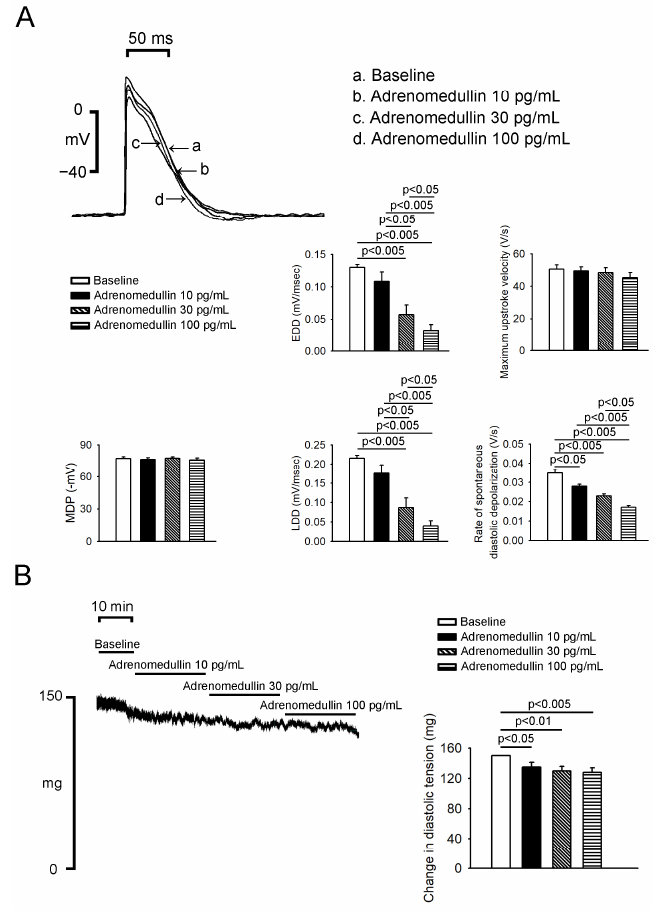
Figure 2. Effects of adrenomedullin on PV action potential (AP) morphology and vascular tone. ( A ) The superimposed traces illustrate the effects of adrenomedullin on the PV APs. Adrenomedullin (10–100 pg/mL) reduced the rates of spontaneous, early, and late diastolic depolarization. However, adrenomedullin (10–100 pg/mL) did not affect the maximum diastolic potential (MDP) or maximum upstroke velocity in PV tissue ( n = 8). ( B ) Adrenomedullin reduced PV ( n = 8) diastolic tension.